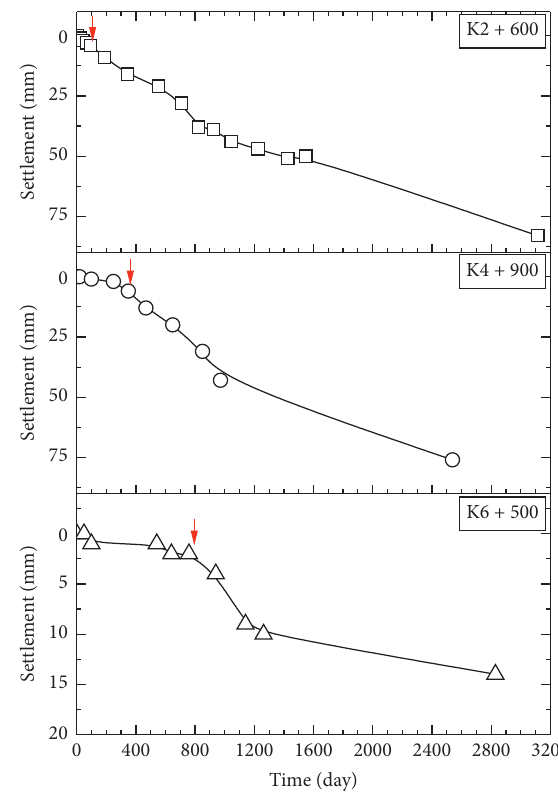
Figure 7: The long-time settlement of the subgrade by time after removing the